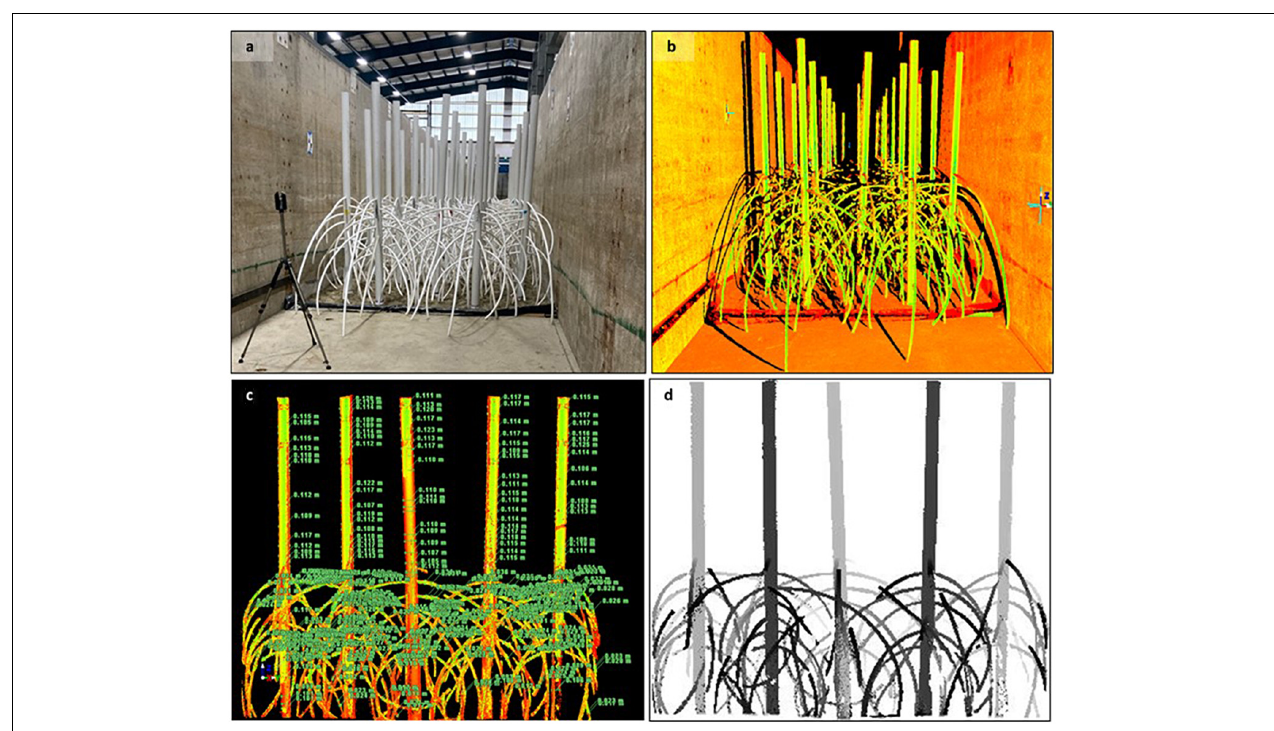
FIGURE 5 | (a) Head-on photograph of HD model forest. (b) Scanned LiDAR image. (c) Extracted stencil showing measurements of trunk and prop roots. (d) Pixelated image for calculating projected area per unit